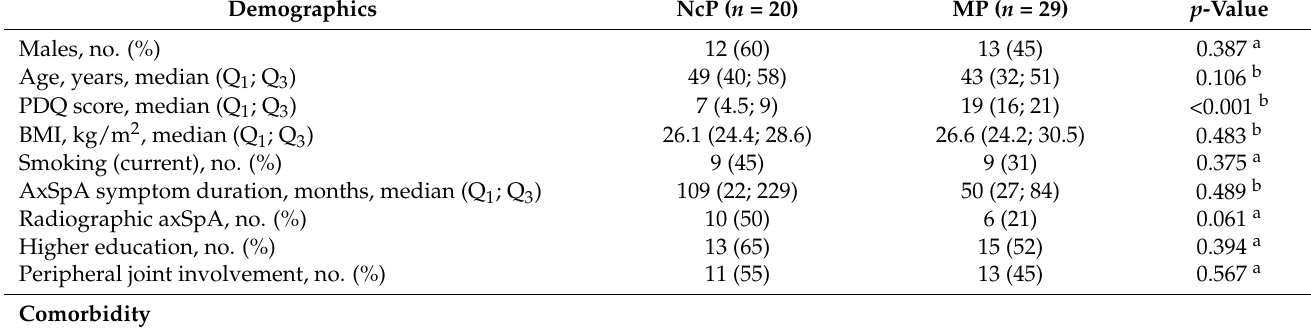
Table 1. Baseline characteristics according to pain phenotype, nociceptive pain (NcP) and mixed pain (MP).